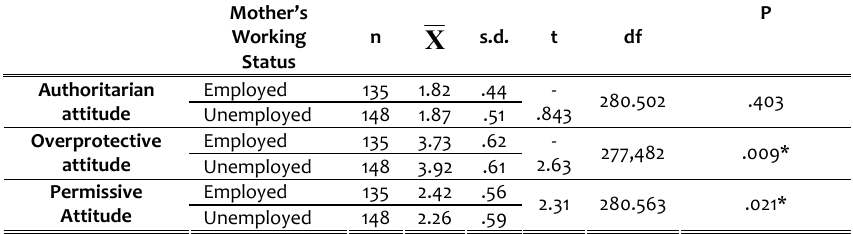
Table 9. Results of t-test on the total scores of PAS subscales and the mother’s working